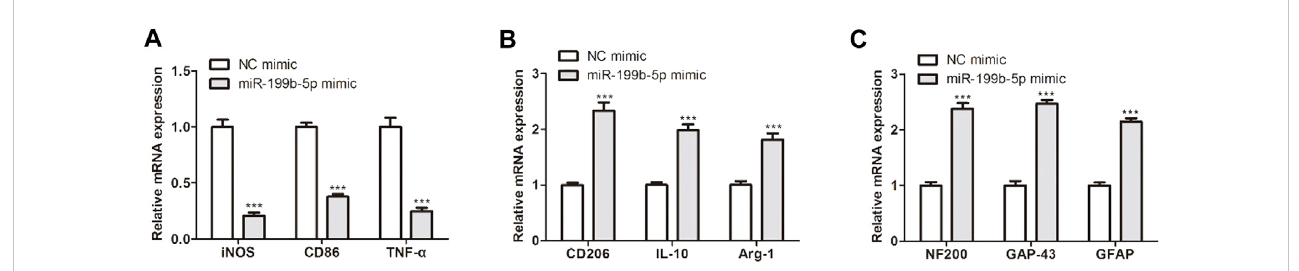
FIGURE 5 MiR-199b-5ppolarizedmacrophagesintoM2phenotypeandpromotedneuronalregeneration invitro . (A) RT-qPCRdetectedtheM1markerexpression (iNOS, CD86 and TNF- α ) after transfection. (B) RT-qPCR showed the M2 marker expression (CD206, IL-10, and Arg1). (C) RT-qPCR measured the expression of NF200, GAP-43, and GFAPT. *** p < .001 vs. the NC mimic.